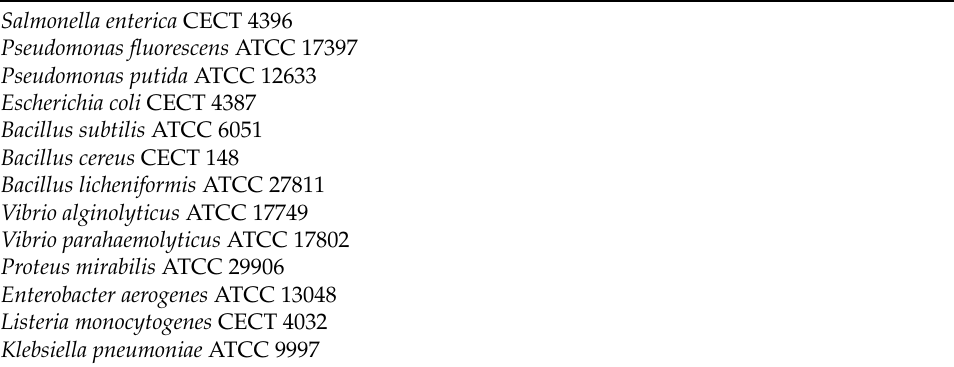
Table 1. Pathogenic and spoilage bacteria selected for the microbial inhibition